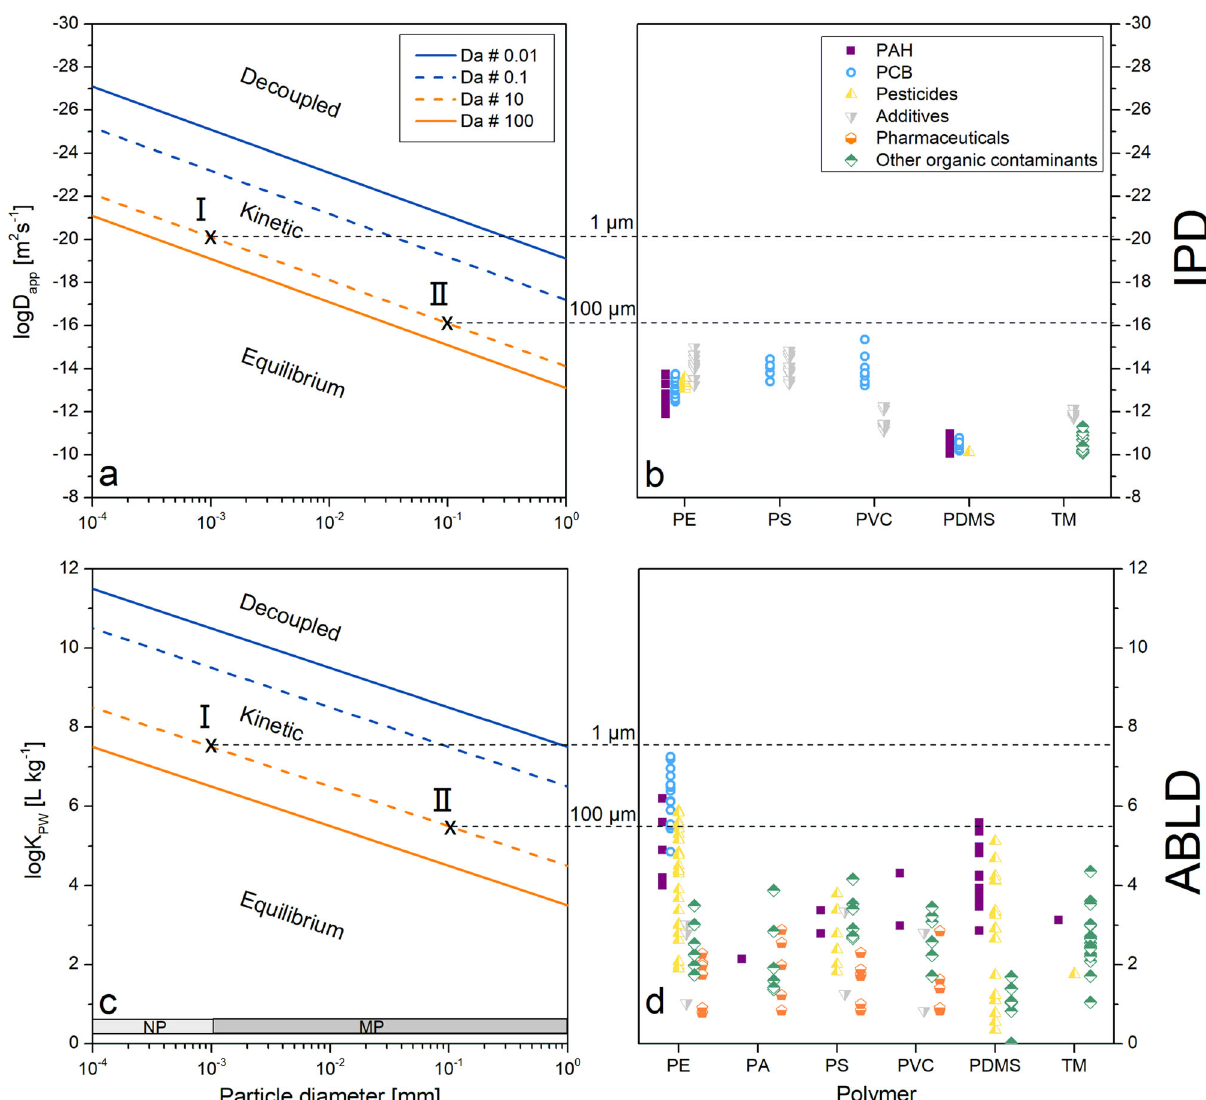
Fig. 2 Identi fi cation of MNP-facilitated transport of contaminants in farmland soils for a travel time of 1 m a − 1 using Damköhler numbers. Lines of equal Damköhler numbers indicate equilibrium conditions (>10 − 100) and decoupled transport (<0.1 − 0.01) depending on the particle size ( x -axis) and a the log D app for IPD or c log K PW for ABLD ( y -axis). b Log D app 30,39,71 – 77 and d log K PW 30,37 – 40,55,59,78 – 82 for contaminant groups and polymers reported